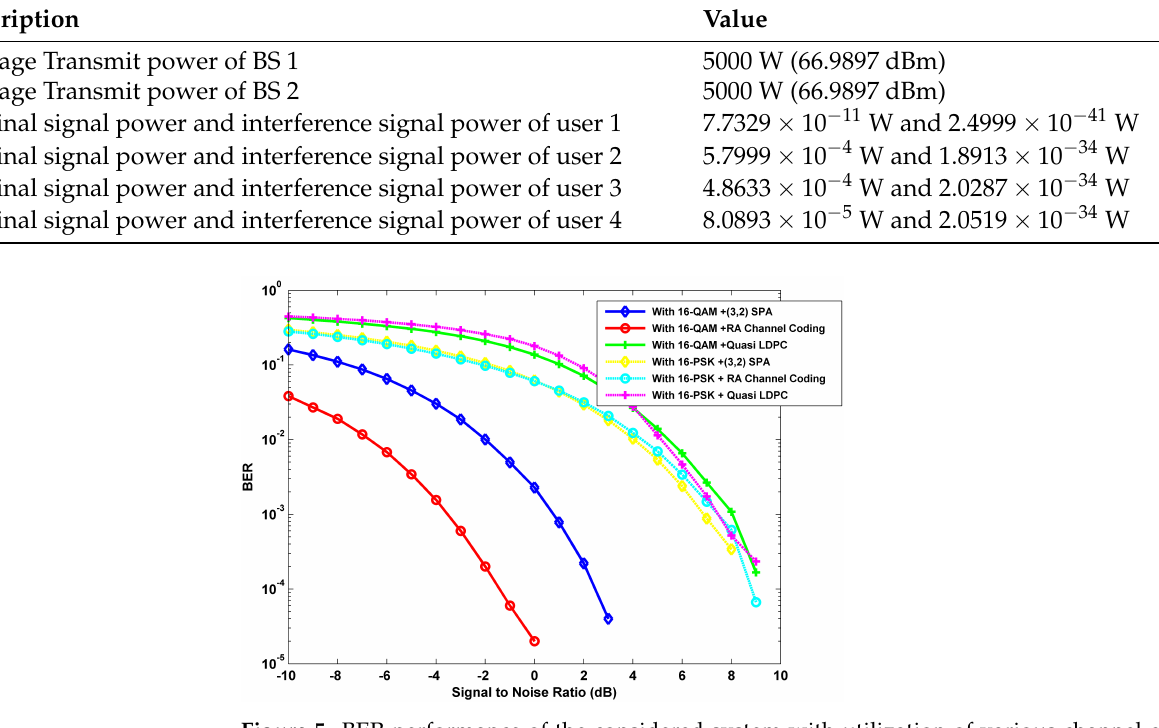
Figure 5. BER performance of the considered system with utilization of various channel coding, higher − order digital modulation, and ZF signal detection technique for user